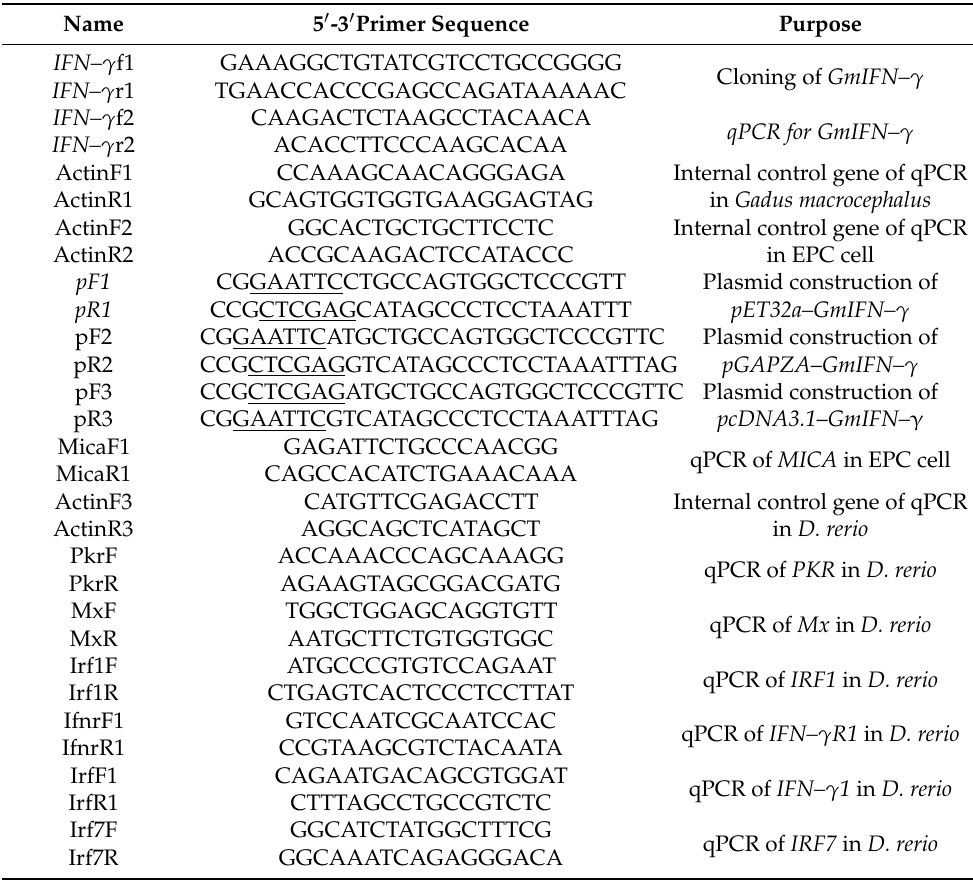
Table 1. Sequence of primers used in this